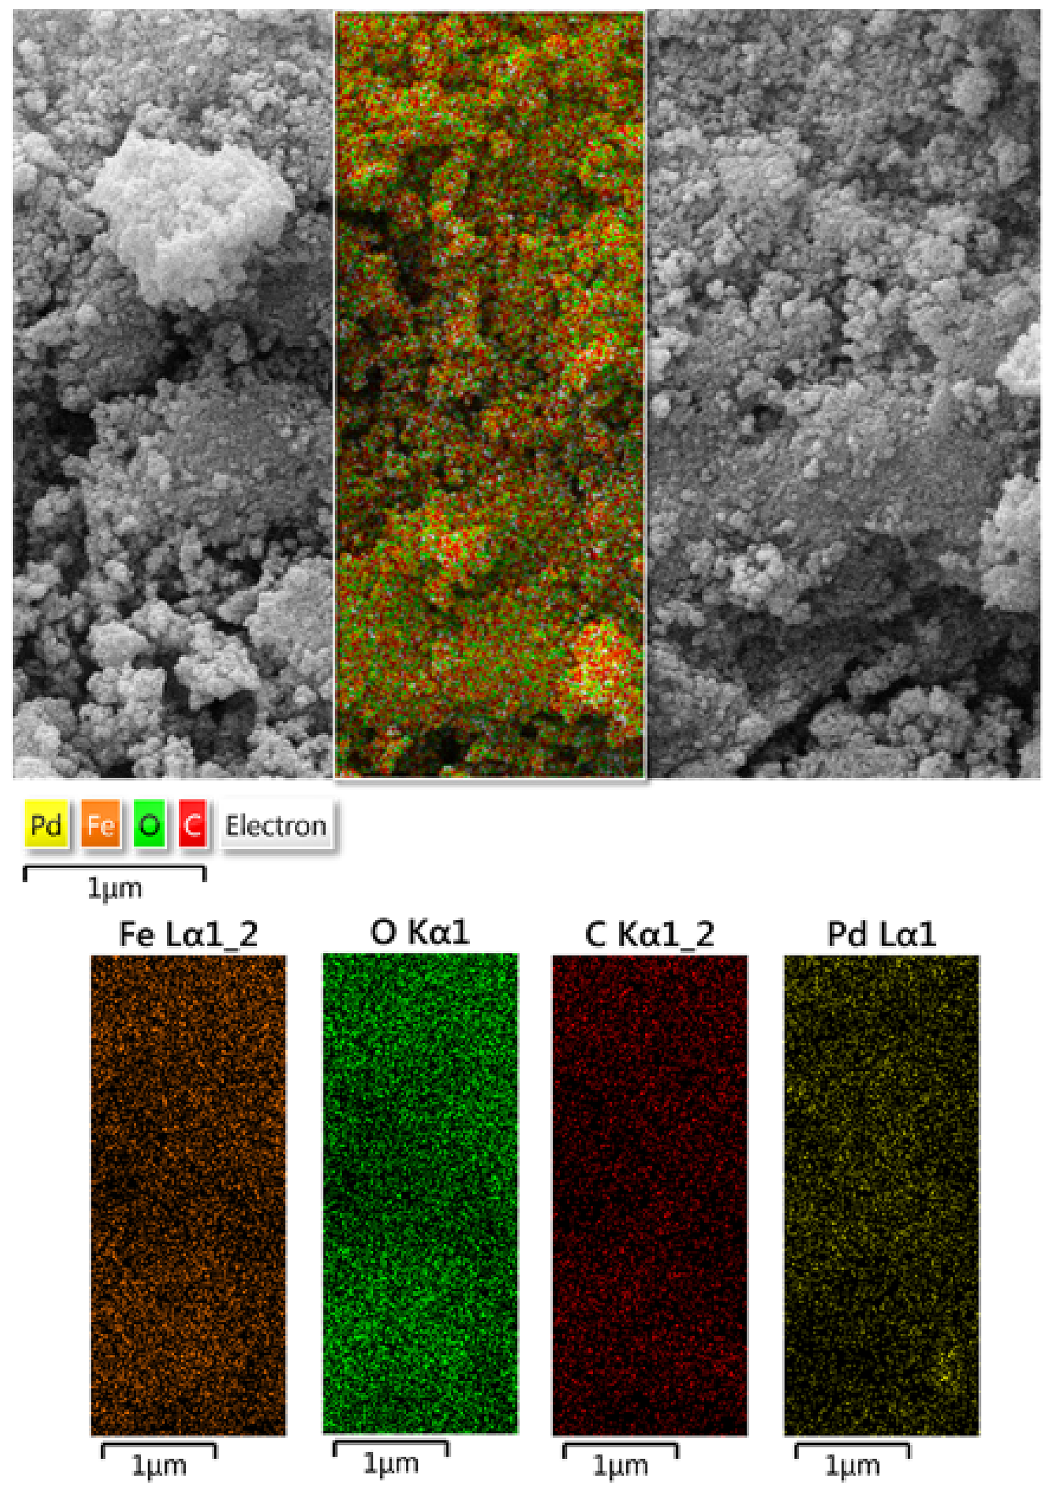
Figure 5. Elemental mapping of Fe 3 O 4 @ Fritillaria /Pd